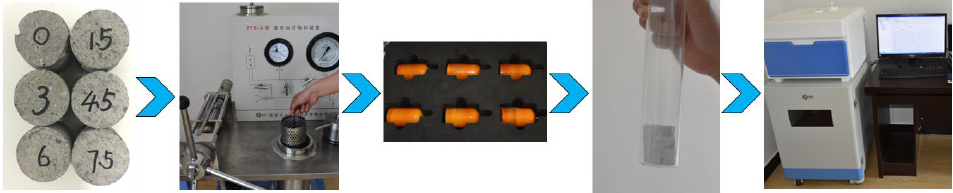
Figure 3. Experimental flow chart of the nuclear magnetic resonance experiment.